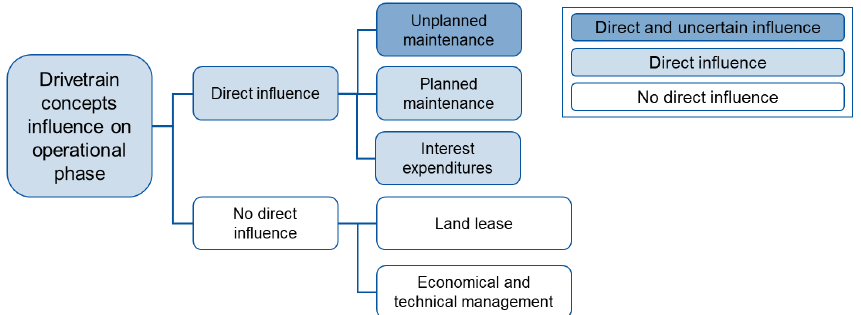
Figure 1. Factors influencing the operational phase of a wind